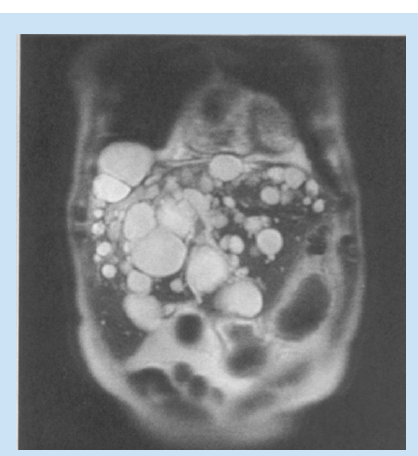
Fig. 3b. MRI confirming multiple hepatic cysts with high signal on T2-weighted images.